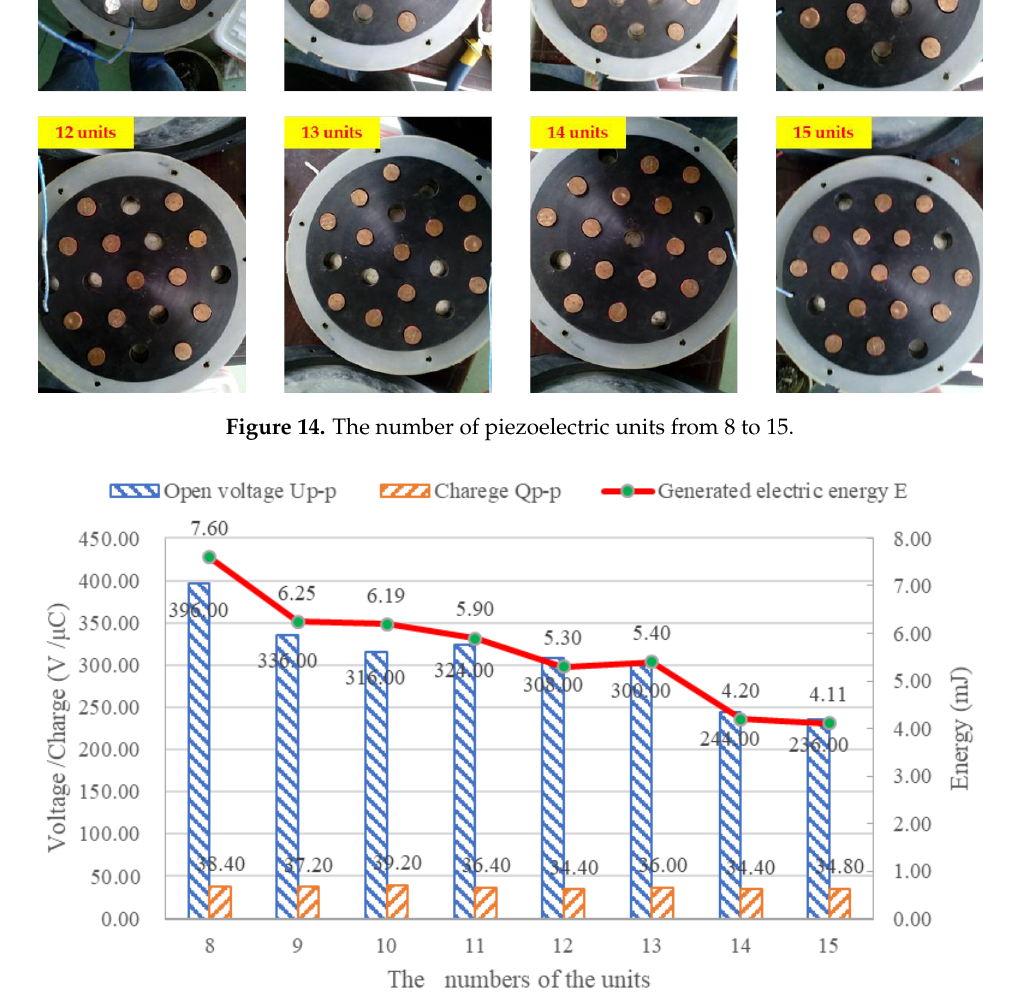
Figure 15. The electric energy signal of the PEH with different numbers of units.